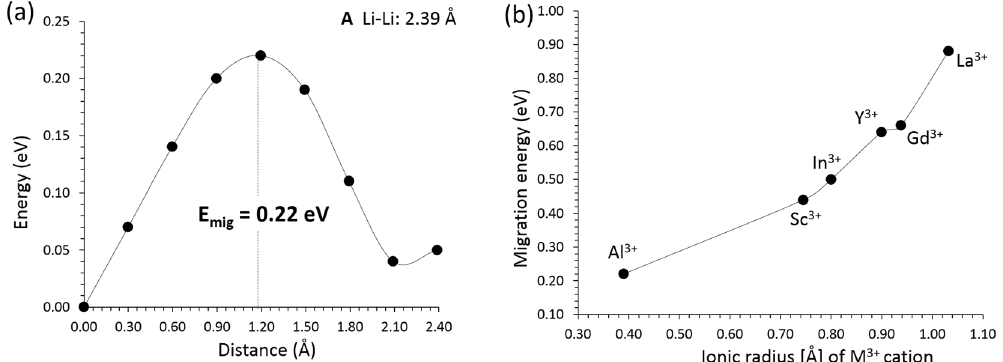
Figure 4. ( a ) The different energy profiles in the vicinity of an Al atom [effectively path (A) in Fig. 2 but with a nearest neighbour Al substitutional dopant] of Li vacancy hopping between two adjacent Li sites in Li 2 CuO 2 . ( b ) The activation energy of migration, E mig , of Li with respect to the ionic radius of the dopants ( R = Al, Sc, In, Y, Gd and La) in the vicinity of the migrating Li